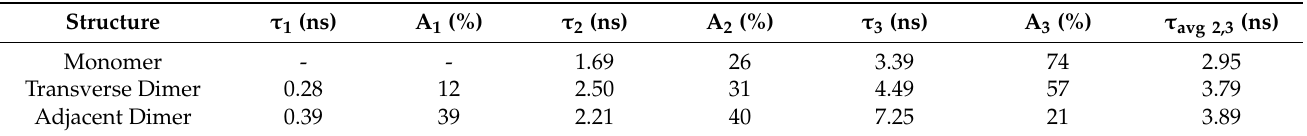
Figure 3. TCSPC decay traces obtained for DNA HJ templated perylene monomer, transverse dimer, and adjacent dimer solutions. The solutions were excited at 405 nm and fluorescence emission was collected at 497 nm. A zoomed-out plot of the same data is shown in the inset. Table 2. Time Constants and Amplitudes Derived from TCSPC Measurements of DNA-Templated Perylene Monomer, Transverse Dimer, and Adjacent Dimer